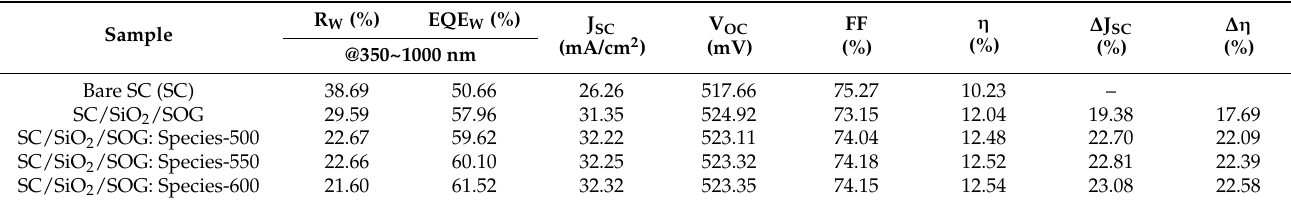
Table 2. Average weighted reflectance ( R W ), average weighted EQE ( EQE W ), and photovoltaic performance of all evaluated solar cells.